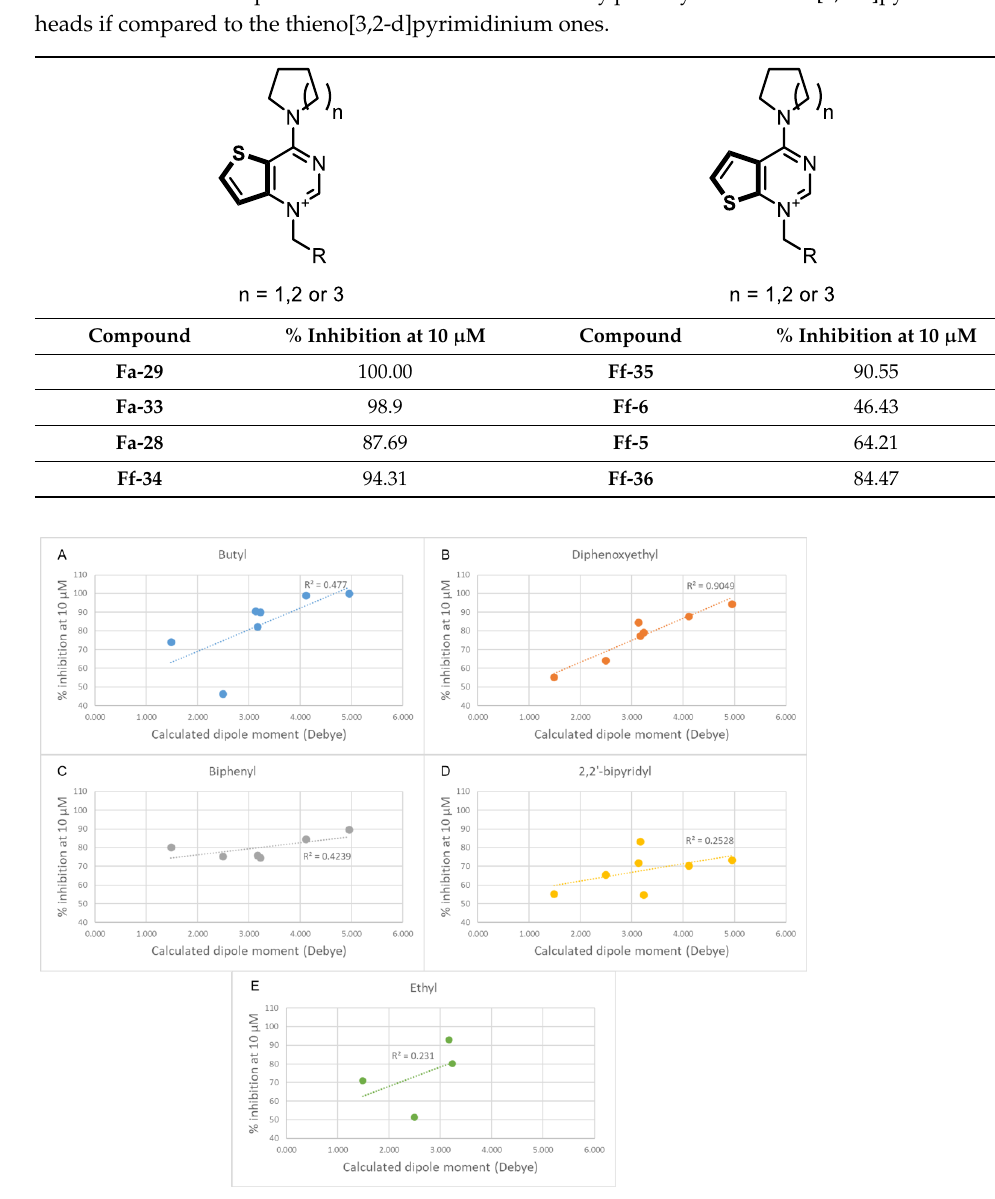
Figure 8. Plot of the experimental percentage inhibition at 10 μM against the calculated dipole moment of the heads for the classes of compounds containing a butyl or ethyl linker (blue dots and orange dots, respectively). The outlier head is circled in blue and the structure is reported on the right. To determine the potency of the compounds, preliminary end-point assays were undertaken with the inhibitors at the concentrations of 10 and 30 μM. Then, the IC 50 values of the most potent inhibitors were determined (Table 4). In general, these values are in agreement with the docking studies. For instance, the larger volume of the qua- ternary amine in the cationic head is still key to the activity, so the azepane ring is pos- tulated to be the most suitable, especially when the spacer is longer. The introduction of